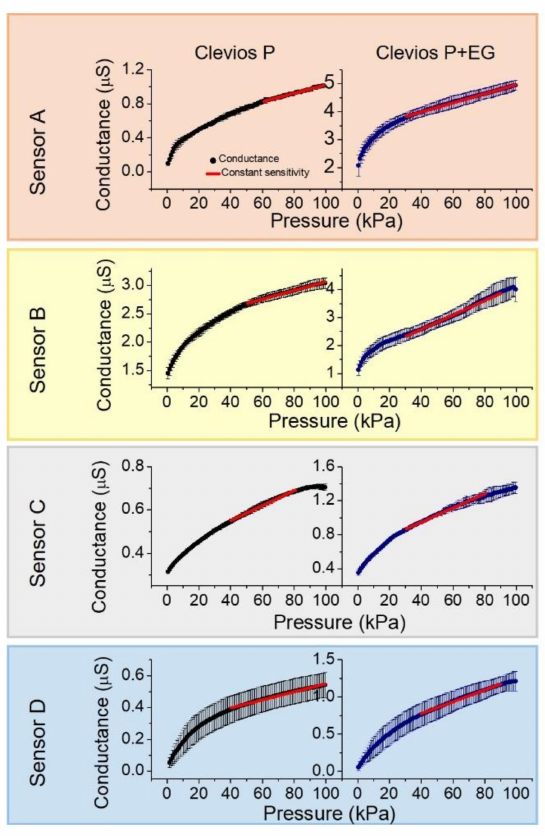
Figure 6. Average trend over ten cycles of the conductance response during compression stress for both